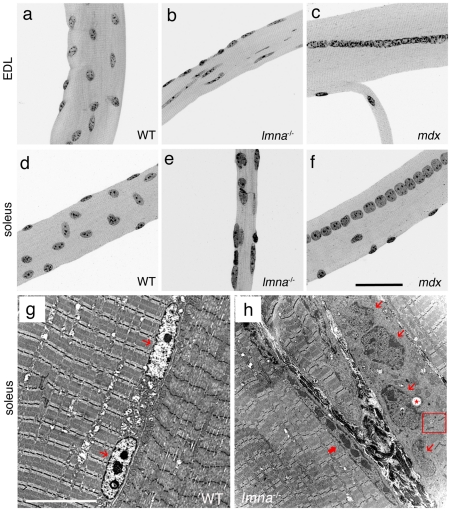
Myonuclear morphology is abnormal in lmna-null mice.DAPI staining of representative EDL and soleus myofibres from wild-type (WT) lmna+/+mice show that myonuclei are evenly distributed and have similar shape, size and heterochromatin content (a and d). By contrast, myonuclei in lmna
−/− myofibres are unevenly distributed, with variable size and shape, and heterogeneous chromatin content and distribution (b and e). Myofibres isolated from the mdx mouse model of DMD contain myonuclei of a more regular size, shape and heterochromatin organization (c and f). Unlike in lmna
−/− myofibres, myonuclei in mdx mice are often located in a chain in the centre of the myofibre, indicative of a recent regenerative event (c and f). Representative TEM images of longitudinal sections of soleus muscle from wild-type lmna+/+ (g) and lmna
−/− (h) mice. WT myonuclei (thin red arrows) are regularly shaped, and have an even layer of highly condensed chromatin around the nuclear rim, in addition to centrally located condensations (g). Myonuclei (thin red arrows) from lmna null mice are irregularly shaped and have disorganized chromatin throughout with occasional vacuoles (h - red *). A thick red arrow indicates an abnormally elongated myonucleus. Note connective tissue between myofibres and the disruption of the sarcomeric arrangements near the abnormal myonuclei (red open square). Scale bar for (a–f) is 50 µm and 10 µm for (g and h).